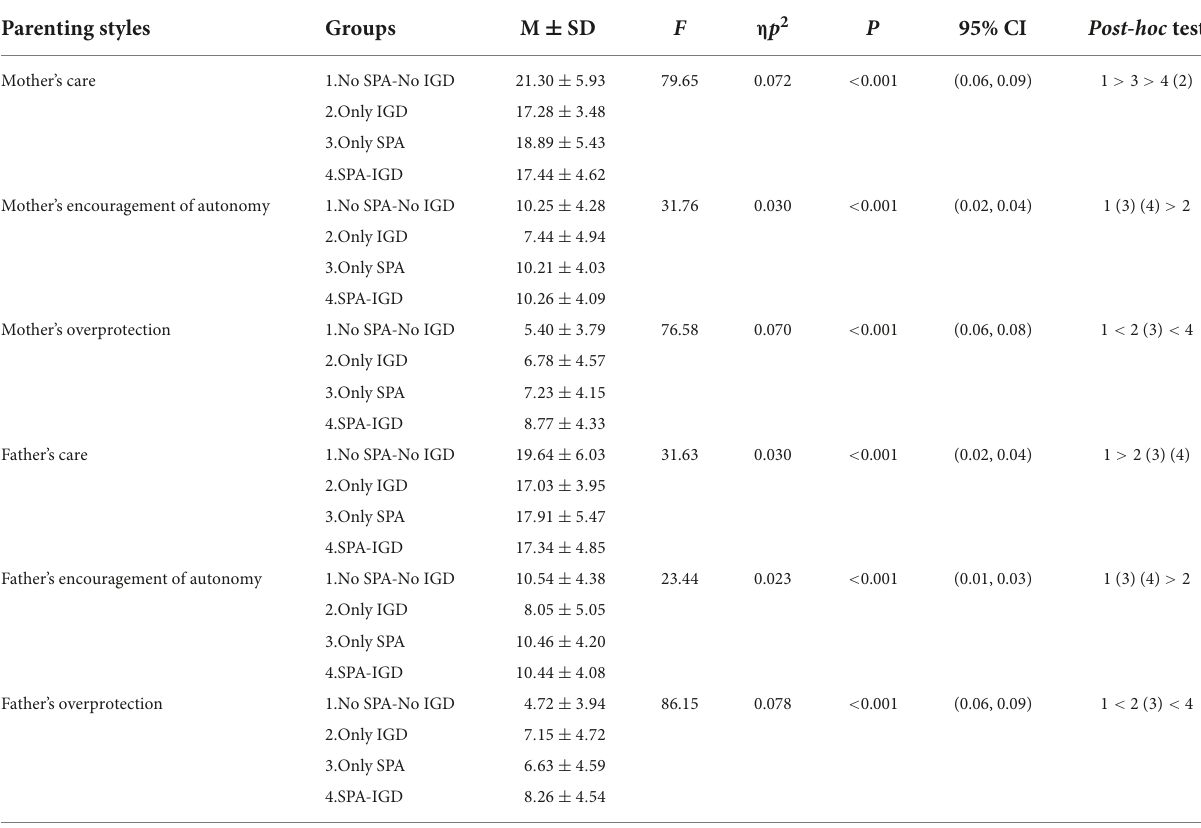
TABLE 3 Differences in parenting styles among the four groups ( n =